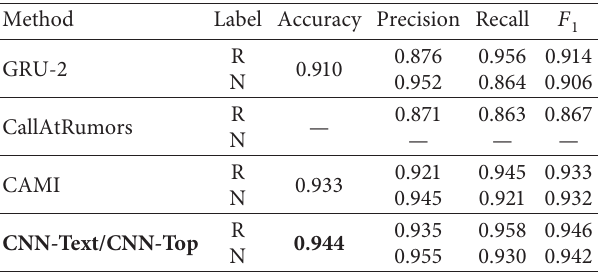
Table 6: Performance of feature aggregation model (R: rumor; N: nonrumor).